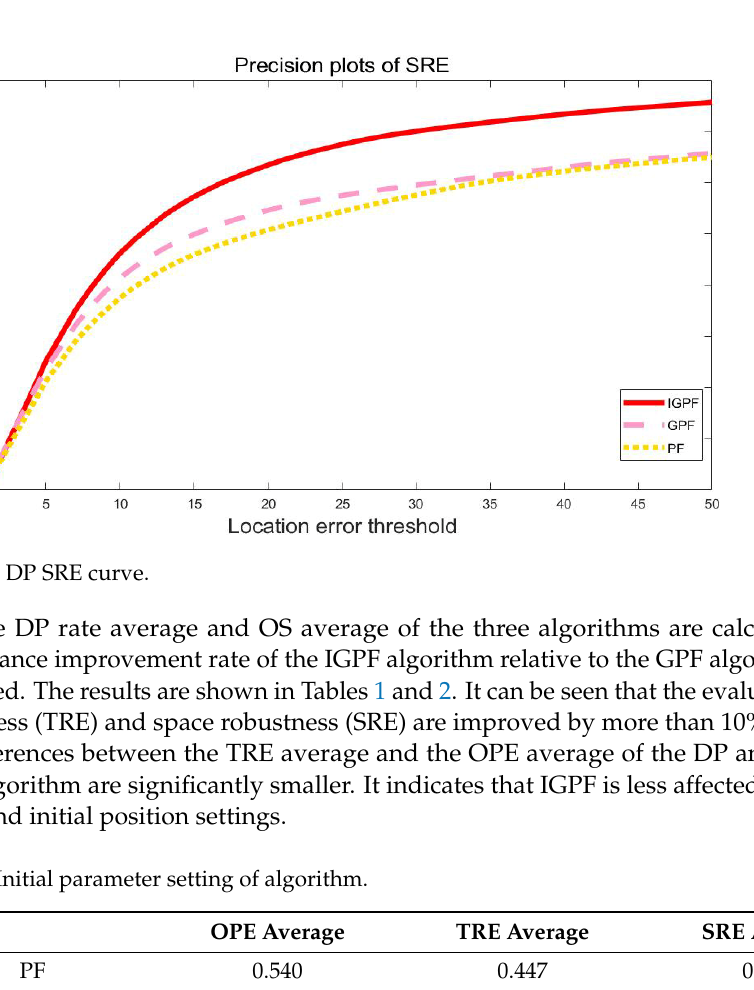
Figure 8. OS SRE curve.